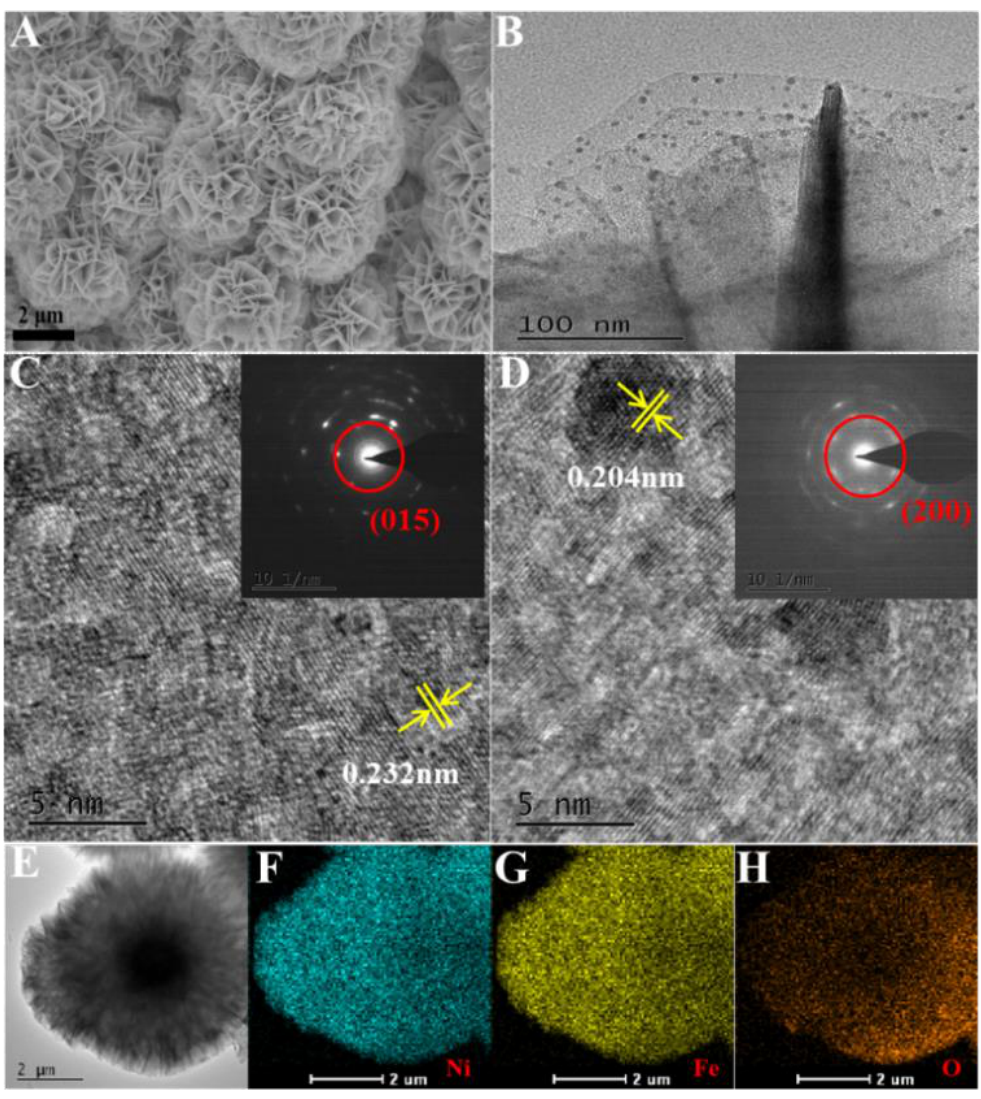
Figure 2. SEM ( A ) of NiFe-LDH, TEM ( B ) of Au/NiFe-LDH/FTO, HRTEM images of NiFe-LDH ( C ), and Au/NiFe-LDH/FTO ( D ). The insets are the corresponding selected area electron diffraction patterns. TEM ( E ) of NiFe-LDH and EDS elemental mapping images ( F – H ) of Ni, Fe, and O.